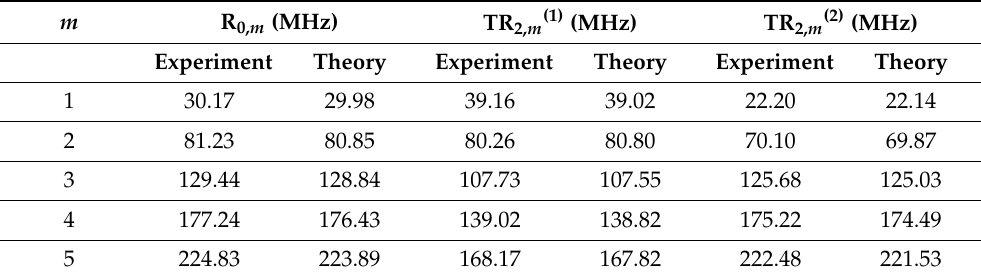
Table 1. Experimental and theoretical values of the frequencies of resonance classified into the series ( 1 ) ( 2 ) R 0, m , TR , and TR , according to their asymptotic behavior. 2, m 2, m m Experiment Theory Experiment Theory Experiment